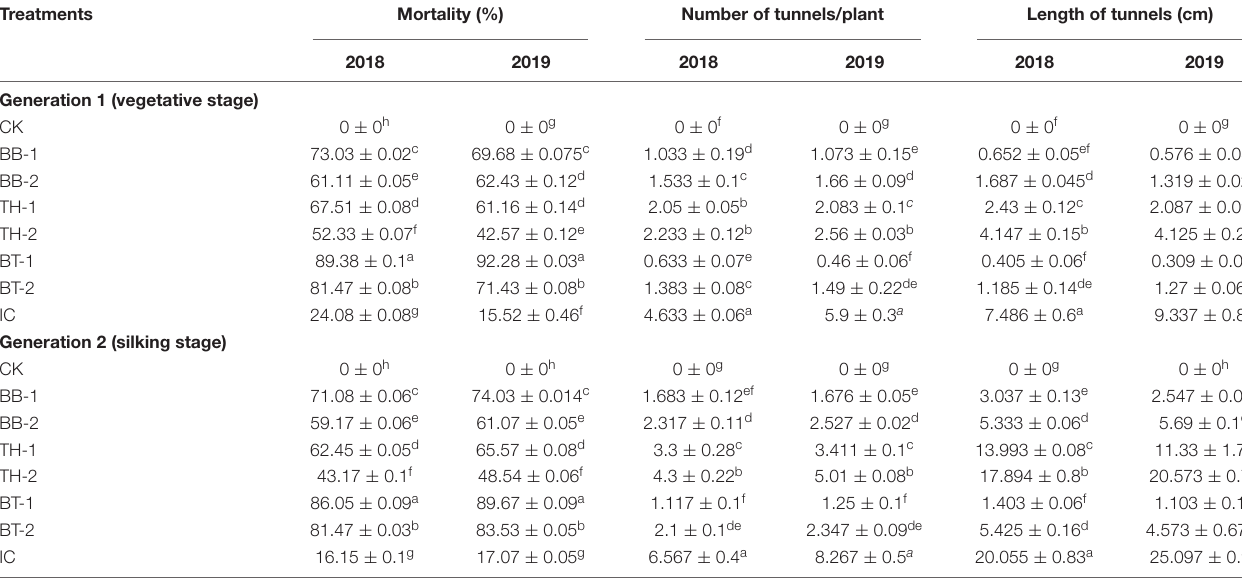
Mean ± SD followed by different lowercase letters indicate significant differences among the treatments (p < 0.05). Treatments include: (CK) untreated control, (BB-1) seed treatment with B. bassiana OFDH1-5, (BB-2) soil drenching with B. bassiana OFDH1-5, (TH-1) seed treatment with T. asperellum GDFS1009, (TH-2) soil